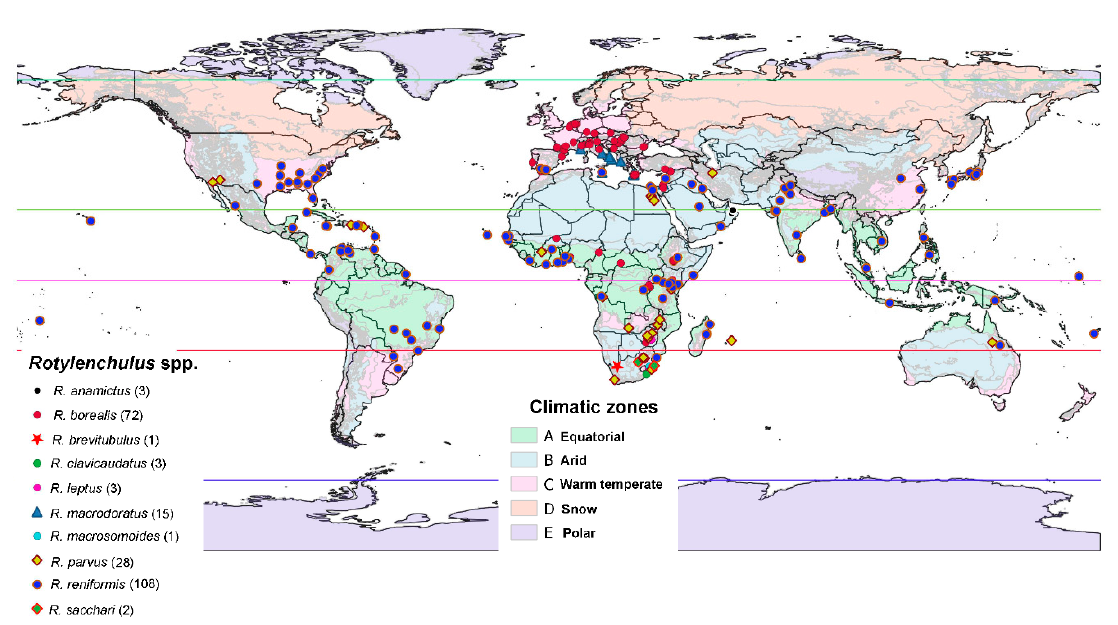
Figure 6. World map distribution of Rotylenchulus species across different climate conditions. Climatic zones based on type of vegetation [19]. In the species list, the number in brackets indicates the locations cited for each species.